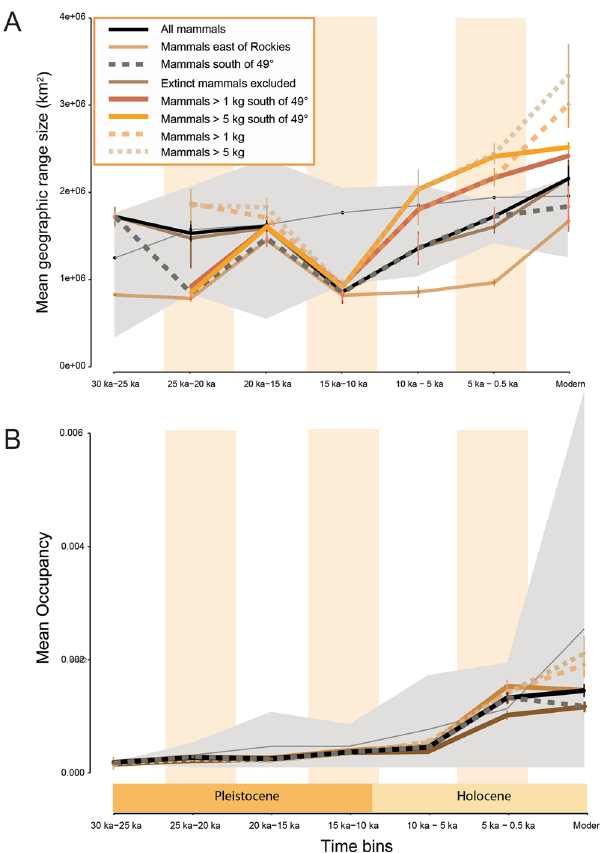
Fig. 3 Mean mammal geographic range size increased from the 15,000 – 10,000 ybp time bin onward but only became signi fi cantly larger than null expectations in the modern time bin when small mammals (<1 kg) are included (sample sizes in Source Data). Mean range size for mammals larger than 1 kg were signi fi cantly larger than null expectations by the 5,000-500 ybp time bin. Neither are associated with increases in range occupancy. A mean geographic range size ± standard error of the mean and B mean occupancy (proportion of 1 ˚ by 1 ˚ grid cells occupied) ± standard deviation. Gray ribbons show the mean of the null model runs (sites shuf fl ed among time bins) with 95% con fi dence